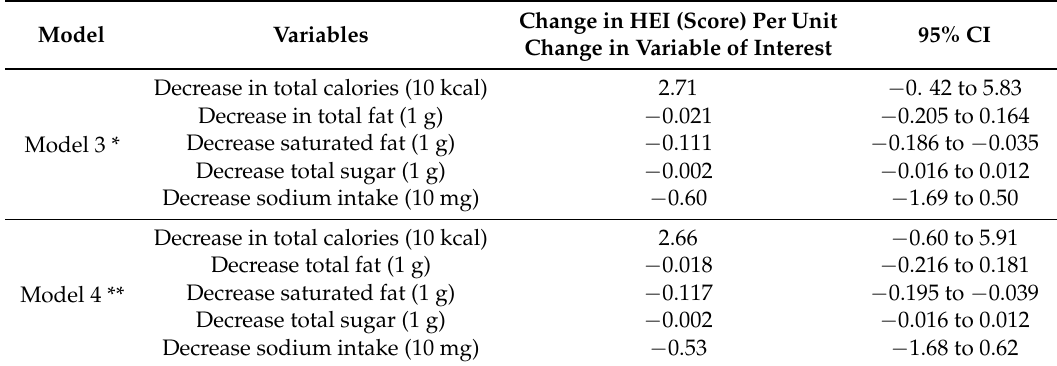
Table 5. Unadjusted and adjusted multiple linear regressions examining variables as predictors of HEI change after the PANDA